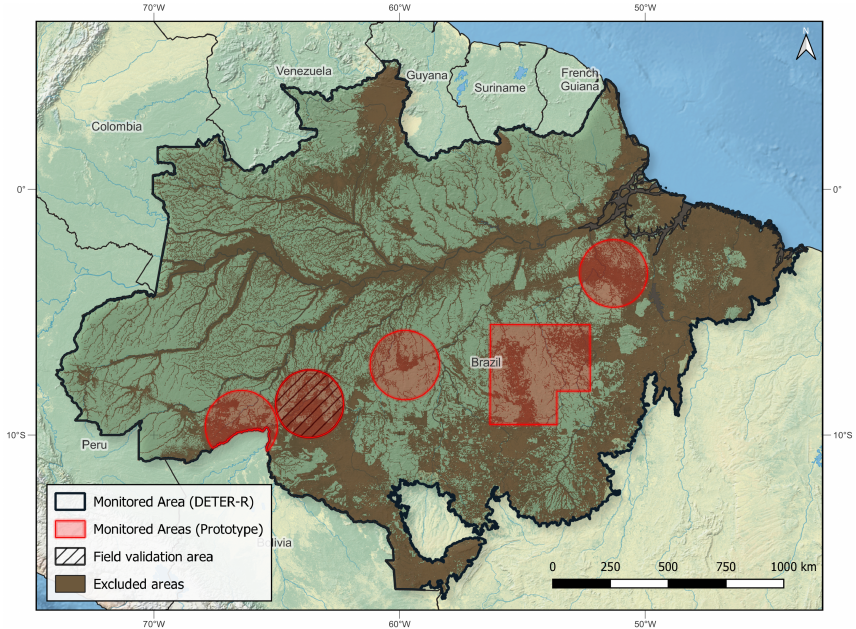
Figure 1. Area being monitored by the DETER-R system. The dark line represents the limit of the Amazon biome within the Brazilian borders. The brown-shaded areas represent regions belonging to the categories not monitored by the DETER-R system: already deforested areas, rivers, flood plains, savannas, beaches, and rocky outcrops. Red areas denote the experimental AOI where DETER-R prototype 2020 testing took place. The hatched circle shows the area of the field validation